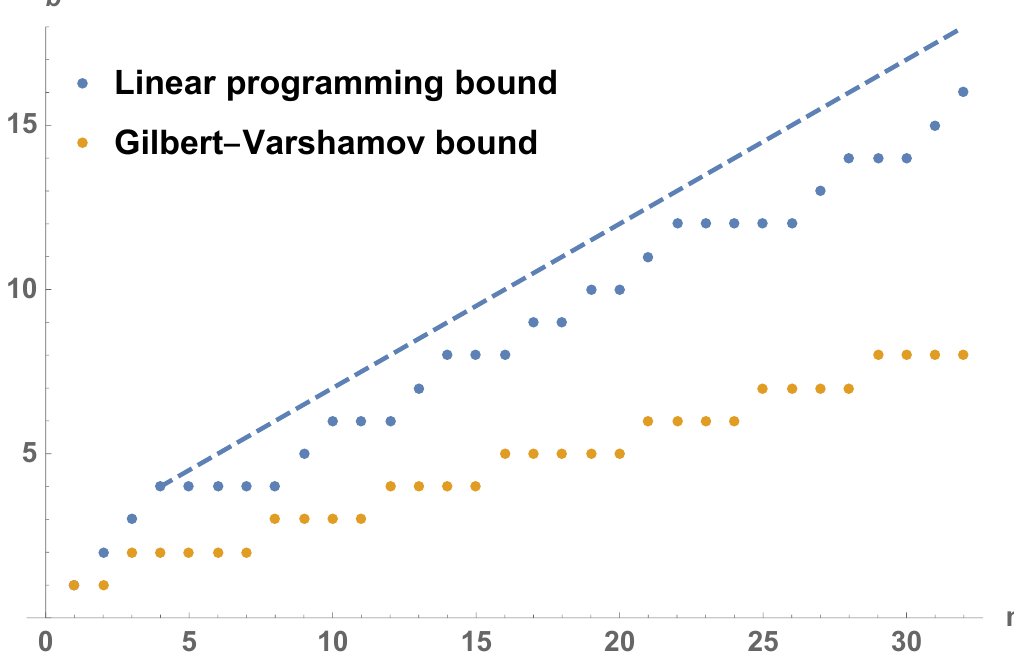
Figure 2 . Blue points: linear programming upper bound on binary Hamming distance d b of real self-dual codes. It is tight for small but presumably not all n . Dashed blue line: an approximate theoretical fit ∆ = n/ 8+1 / 2 of the numerical bootstrap constraint for the maximal value of spectral gap, measured in units of d b = 4∆ [10]. Yellow points: Gilbert-Varshamov lower bound on binary Hamming distance obtained from